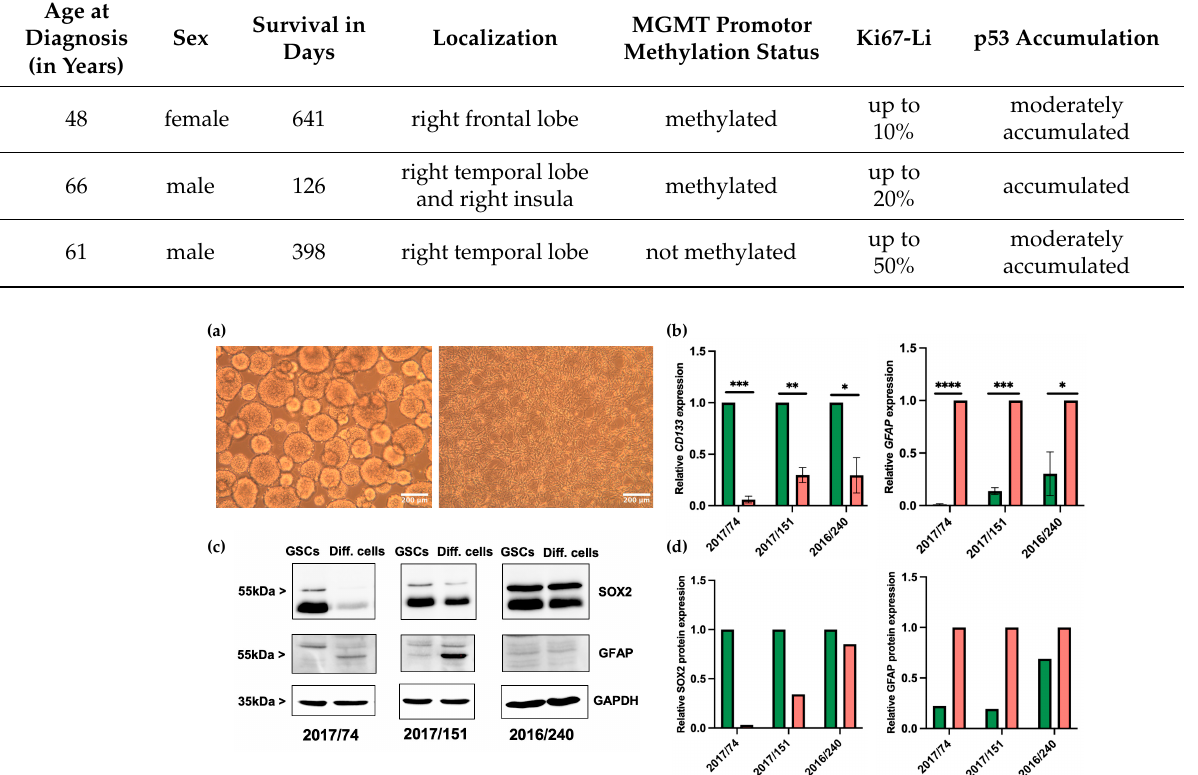
Figure 1. Differentiation of GSCs in astrocytic tumor cells. ( a ) Light microscopy images of 2017/151 spheroid GSCs (left) and adherent differentiated cells (Diff. cells, right). ( b ) Expres- sion of CD133 and GFAP on an mRNA level by RT-qPCR in GSCs (green bars) and corresponding differentiated, astrocytic cells (red bars). Results are given as mean ± SD of three independent experiments. A paired Student’s t -test was applied to determine significance: * p < 0.05, ** p < 0.01, *** p < 0.001, **** p < 0.0001. ( c ) Western Blot of GSCs and Diff. cells showing SOX2 and GFAP expression, where GAPDH was used for internal normalization. ( d ) Western Blot quantification of stem cell marker SOX2 and differentiation marker GFAP in three GSCs lines (green bars) and differentiated cells (red